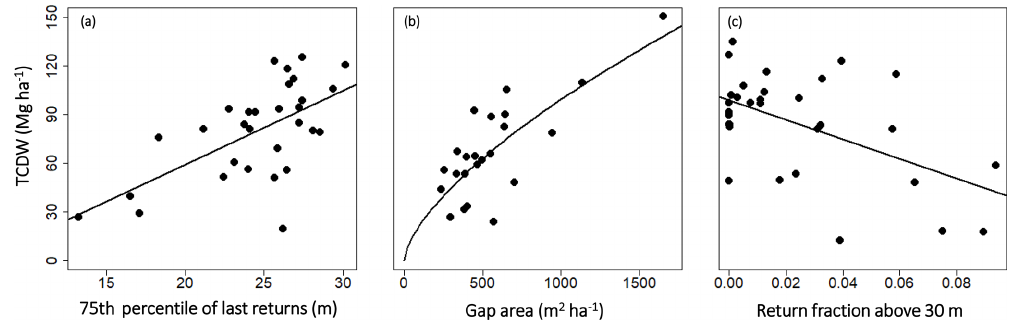
Figure 2. Relationship between total CDW (TCDW) and the best single lidar-based predictor variable of TCDW: (a) the 75th percentile of last returns (m) ( n = 30) for transects classified as intact; (b) gap area (m 2 ha − 1 )( n = 23) for reduced-impact logging transects; (c) return fraction above 30m (last returns) for transects classified as burned ( n = 30). (a) ln(TCDW) = 1 . 96 + 0 . 08 75th percentile of last returns. P< 0 . 01; adjusted R 2 : 0.36. (b) TCDW = 1.04 gap area 0 . 66 . P< 0 . 01; adjusted R 2 : 0.57. (c) ln(TCDW) =− 3 . 97–11.95 return fraction above 30m. P< 0 . 01; adjusted R 2 :